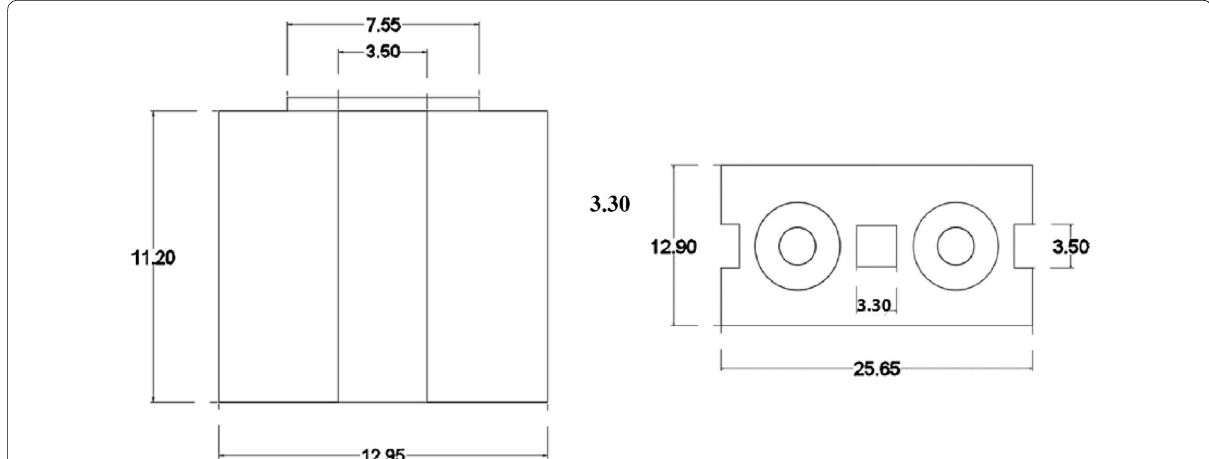
Fig. 1 Typical dimensions of the interlocking brick in cm (side view and top view)